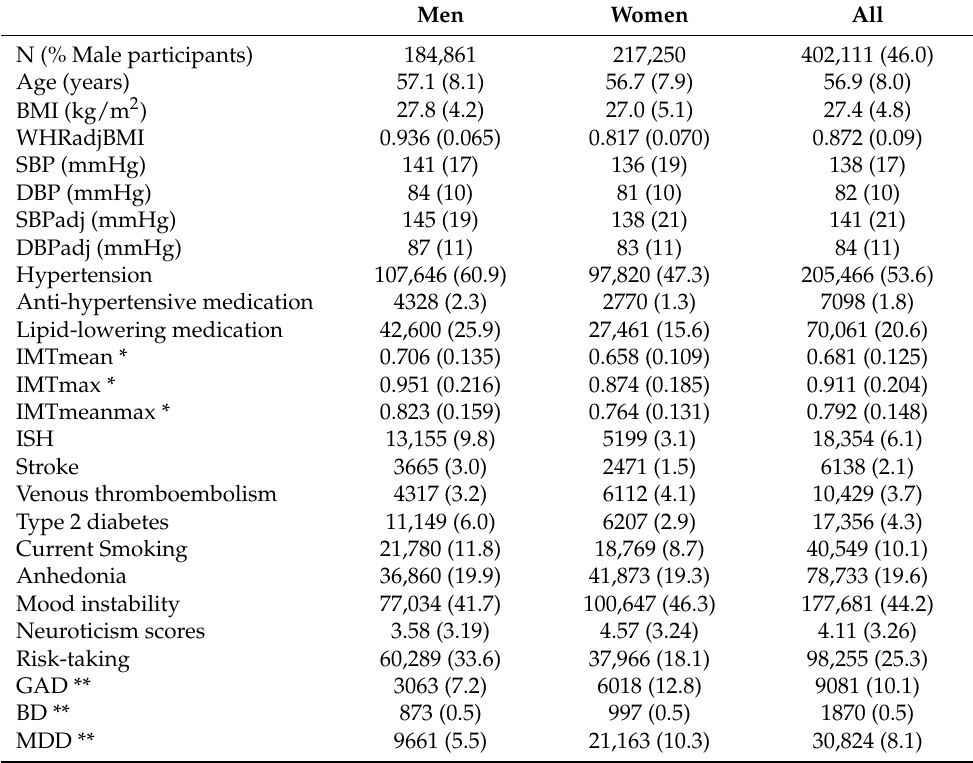
Table 1. Descriptions of the UK Biobank participants included in this